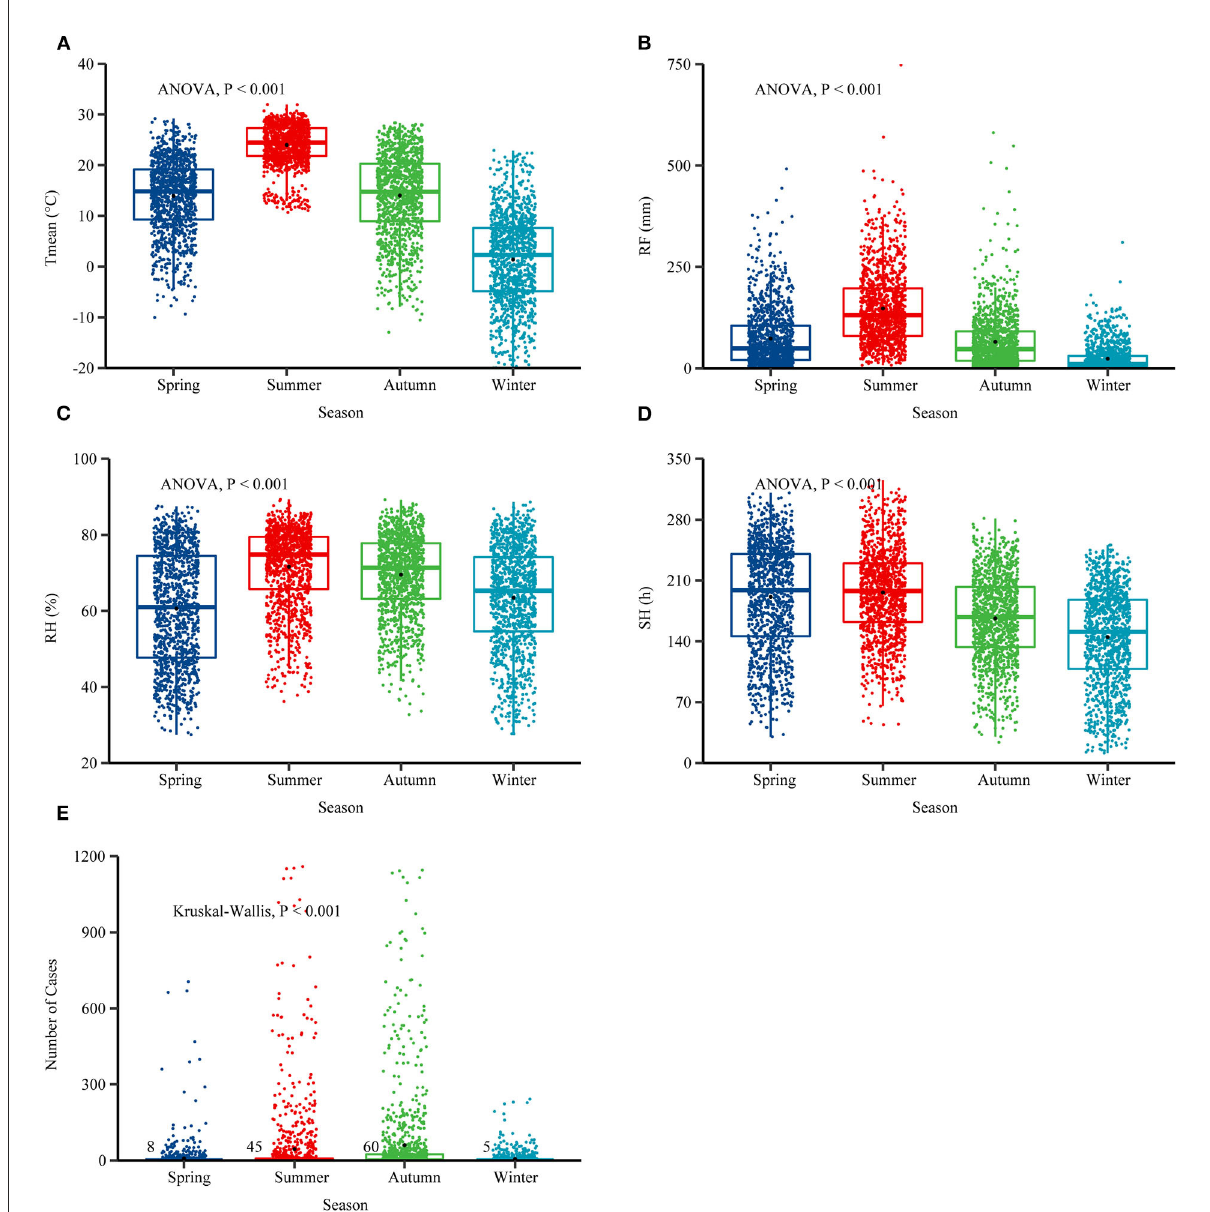
FIGURE4 Boxplots of four meteorological conditions and the number of scrub typhus cases in four seasons from 2006 to 2018. (A–D) Seasonal patterns of weather conditions. (E) Seasonal patterns of scrub typhus. The analysis of variance (ANOVA) test was applied to test whether the values between the four seasons were statistically significant. The Kruskal-Wallis test was used to detect the cases of scrub typhus in four seasons, spring (March-May), summer (June-August), autumn (September-November) and winter (December-February). Mean temperature (Tmean), rainfall (RF), sunshine hours (SH), and relative humidity